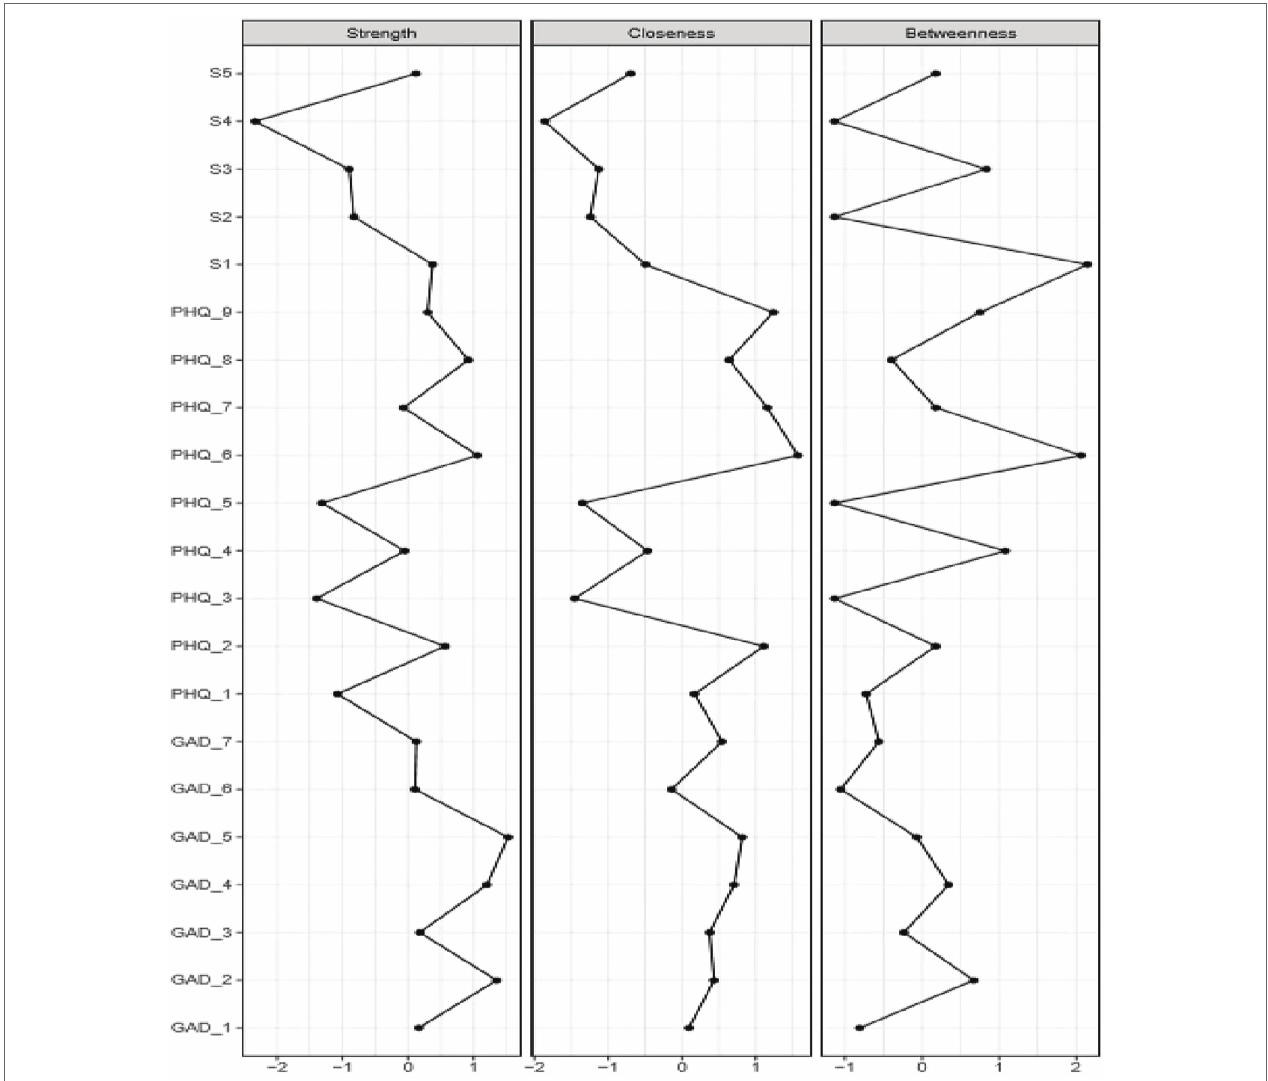
FIGURE 2 | Betweenness, closeness, and node strength centrality estimates for nine PHQ-9 depression symptoms (PHQ_1–PHQ_9), seven GAD-7anxiety symptoms (GAD _1–GAD_7), and five FPI infertility related stress symptoms (s 1–s5). PHQ-9, Patient Health Questionnaire-9; GAD-7; Generalized Anxiety Disorder-7; FPI, Fertility Problem Inventory; sl, Social concern; s2, Relationship concern; s3, Need for parenthood; s4, Rejection of childless lifestyle; and s5, Sexual